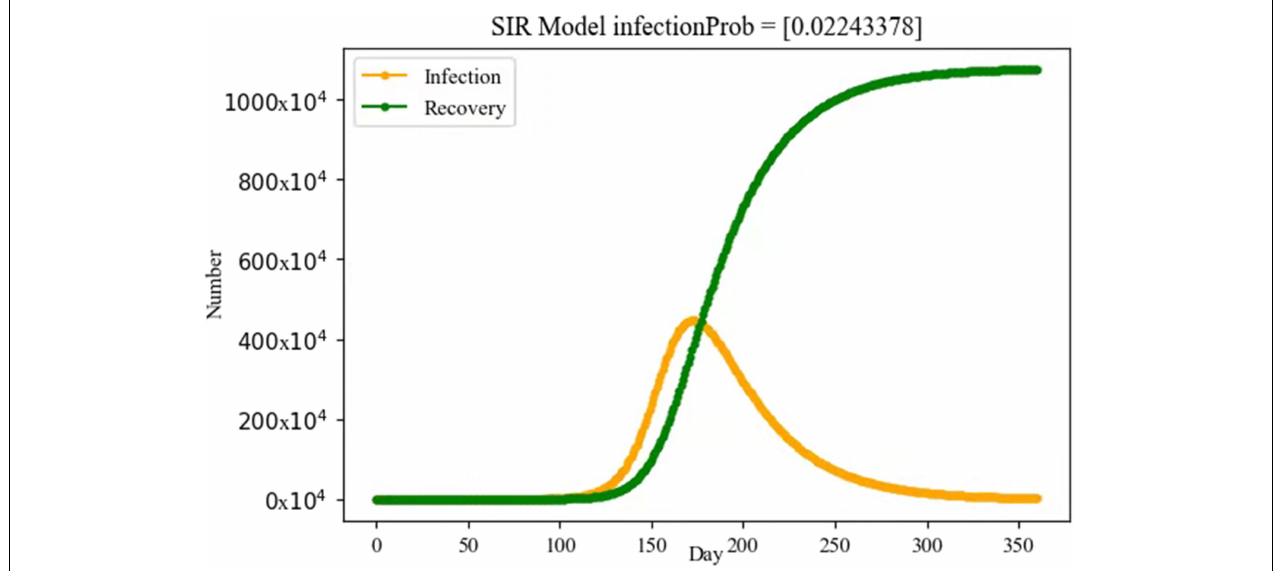
FIGURE 3 | Simulation of the numerical change curve through SIR model for the Yangzhou epidemic. Yellow line: number of infected persons. Green line: number of recovery